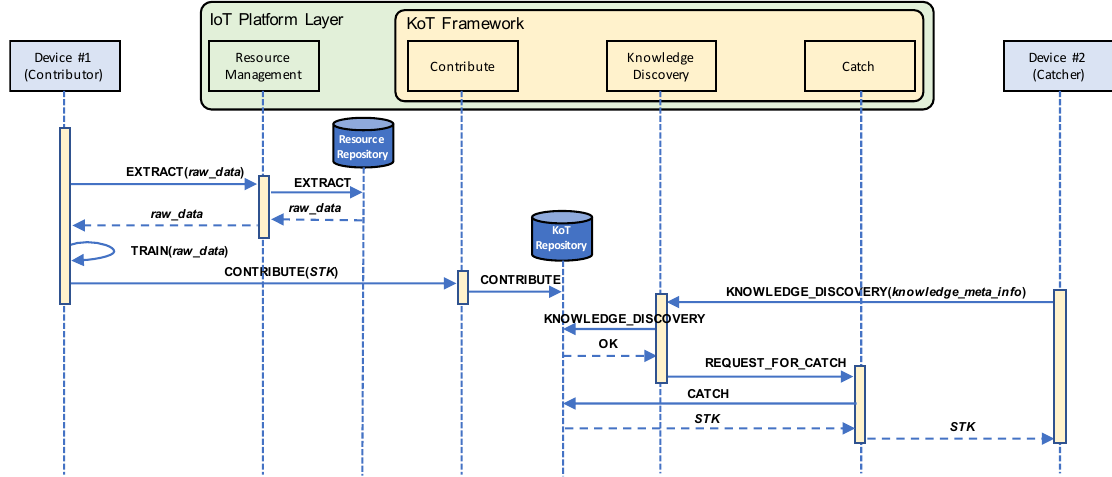
Figure 3. Sequence diagram of sharing of self-taught knowledge between two IoT